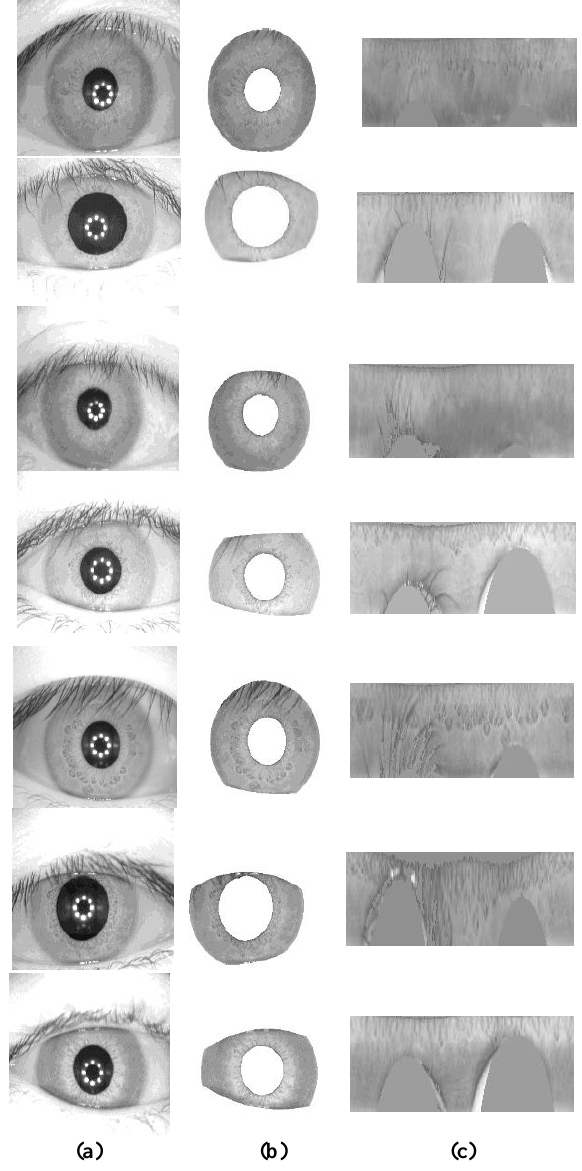
Figure 14. Results of the proposed method on CASIA databases: (a) Original image (b) Segmented image (c) Output of the normalization stage